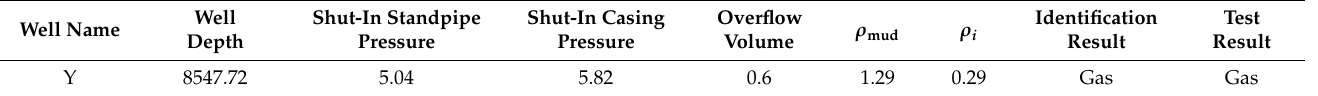
Table 5. Identification results of overflow fluid